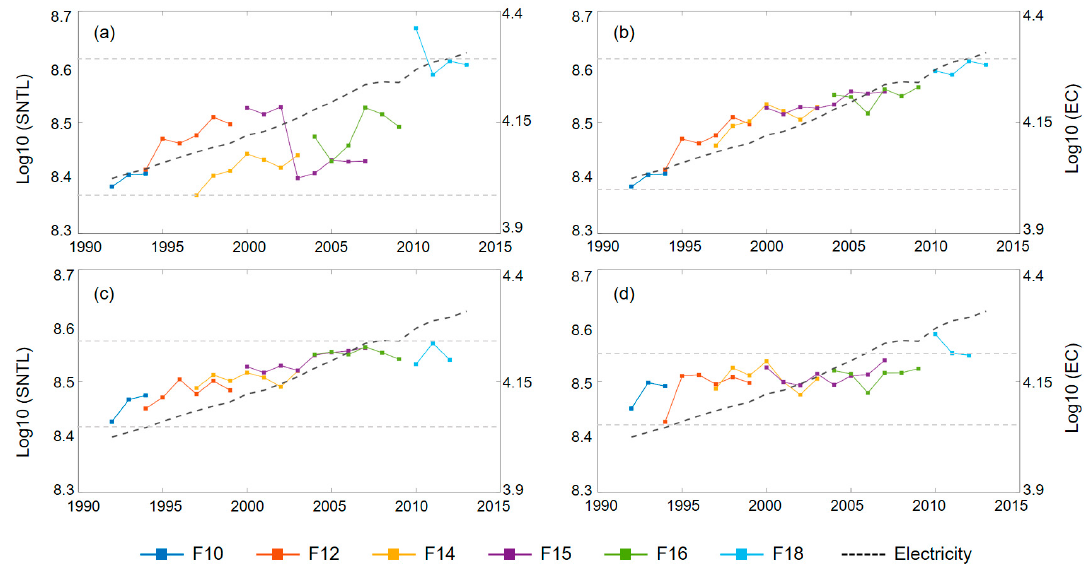
Figure 8. Electricity consumption (EC) and global SNTL (1992–2013) from ( a ) the raw NTL; ( b ) the stepwise calibrated NTL; ( c ) the calibrated NTL from Zhang et al. [15]; and ( d ) the calibrated NTL from Elvidge et al. [17]. The dotted gray line is EC (unit: billion kWh), and the dotted horizontal lines represent the approximate range of SNTL during the past two decades.